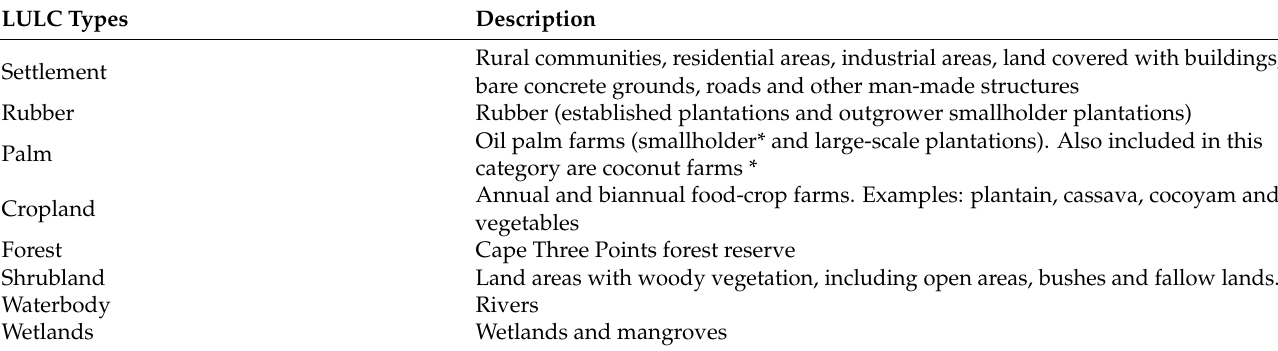
Table 2. Classification scheme of land cover types used in the